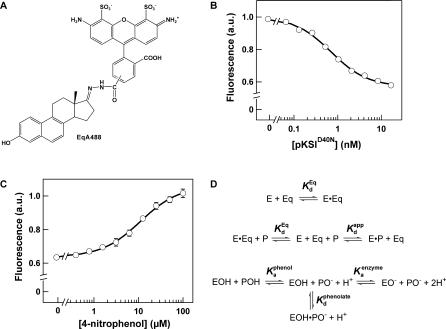
Binding Assay for Phenolates via Competition with a Fluorescently Labeled Equilenin (EqA488–1)(A) Structure of EqA488. Synthesis resulted in two isomers, and the isomer referred to as EqA488-1 was used in further experiments, as described in
Materials and Methods.
(B) Addition of pKSI
D40N (E) to 0.1 nM EqA488–1 (Eq) (pH 6.9) leads to quenching of fluorescence at 515 nm (excitation at 480 nm). Each point is the average of two replicates (with errors smaller than the points). Data were fit to Equation 1 and gave = 0.7 ± 0.1 nM for this determination. Additional replicates gave = 1.0 ± 0.3 nM. The accuracy of this determination does not impact the comparison of the affinities of the substituted phenolates relative to one another.
(C) Addition of 4-nitrophenol (P) to a solution of 0.1 nM EqA488 and 5 nM pKSI
D40N pH 6.9 leads to recovery of fluorescence. Data were fit to
Equation 2 and gave = 11.0 ± 0.9 μM. This observed affinity was first converted to an apparent affinity (= 1.8 ± 0.2 μM;
Equation 3) of the phenol for the enzyme at (pH 6.9). This apparent affinity was then converted into the pH-independent affinity ( = 26 ± 2 nM;
Equation 4) of the phenolate form of the ligand (PO
−) for the protonated form of the enzyme (EOH) using the known phenol and enzyme ionization constants ( = 7.1 and = 5.5, respectively; see
Materials and Methods).
(D) Binding schemes from which
Equations 1–4 were derived.